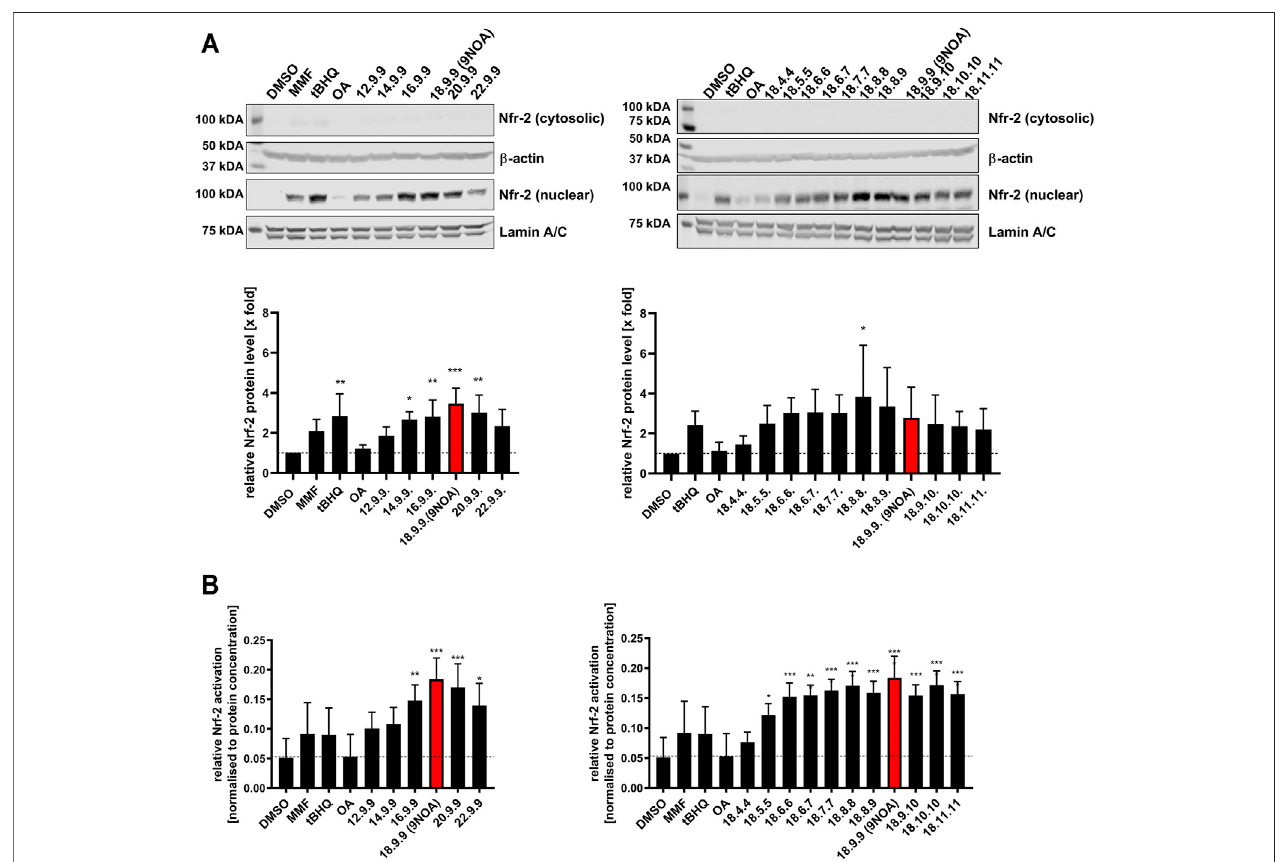
FIGURE 2 | Effects of NFA on Nrf-2 expression in colorectal cancer cells. HCT-116 cells were treated with 10 µM NFA and tBHQ and/or MMF for 4 h, and Nrf-2 levels were analyzed by western blotting and ELISA. (A) Representative western blots of Nrf-2 levels from HCT-116 cells treated with NFA of different carbon chain lengths and different Michael acceptor positions (upper panel). Subcellular fractionation was performed, yielding cytosolic and nuclear extracts. ß-actin and Lamin A/C were used as respective loading controls ( n (cid:2) 4 experiments). Densitometric analysis of Nrf-2 protein levels is shown in the panel below. Cytosolic Nrf-2 protein levels were normalized against ß-actin and nuclear Nrf-2 levels against Lamin A/C. (B) Nrf-2 expression levels were evaluated with an ELISA after incubation with NFA with different carbon chain lengths and Michael acceptor positions. Values are normalized to protein concentration. Data are represented as mean ± SD of n (cid:2)